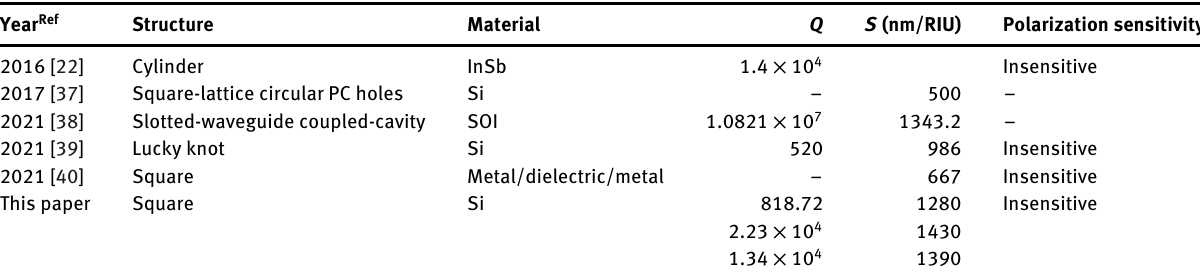
Figure 11: Refractive sensing performance of the asymmetric metasurface. (a) Trans- mission spectra of the metasurface with different refractive indices of analytes. (b) The resonant frequency shift of three Fano modes with different refractive indices of analytes.